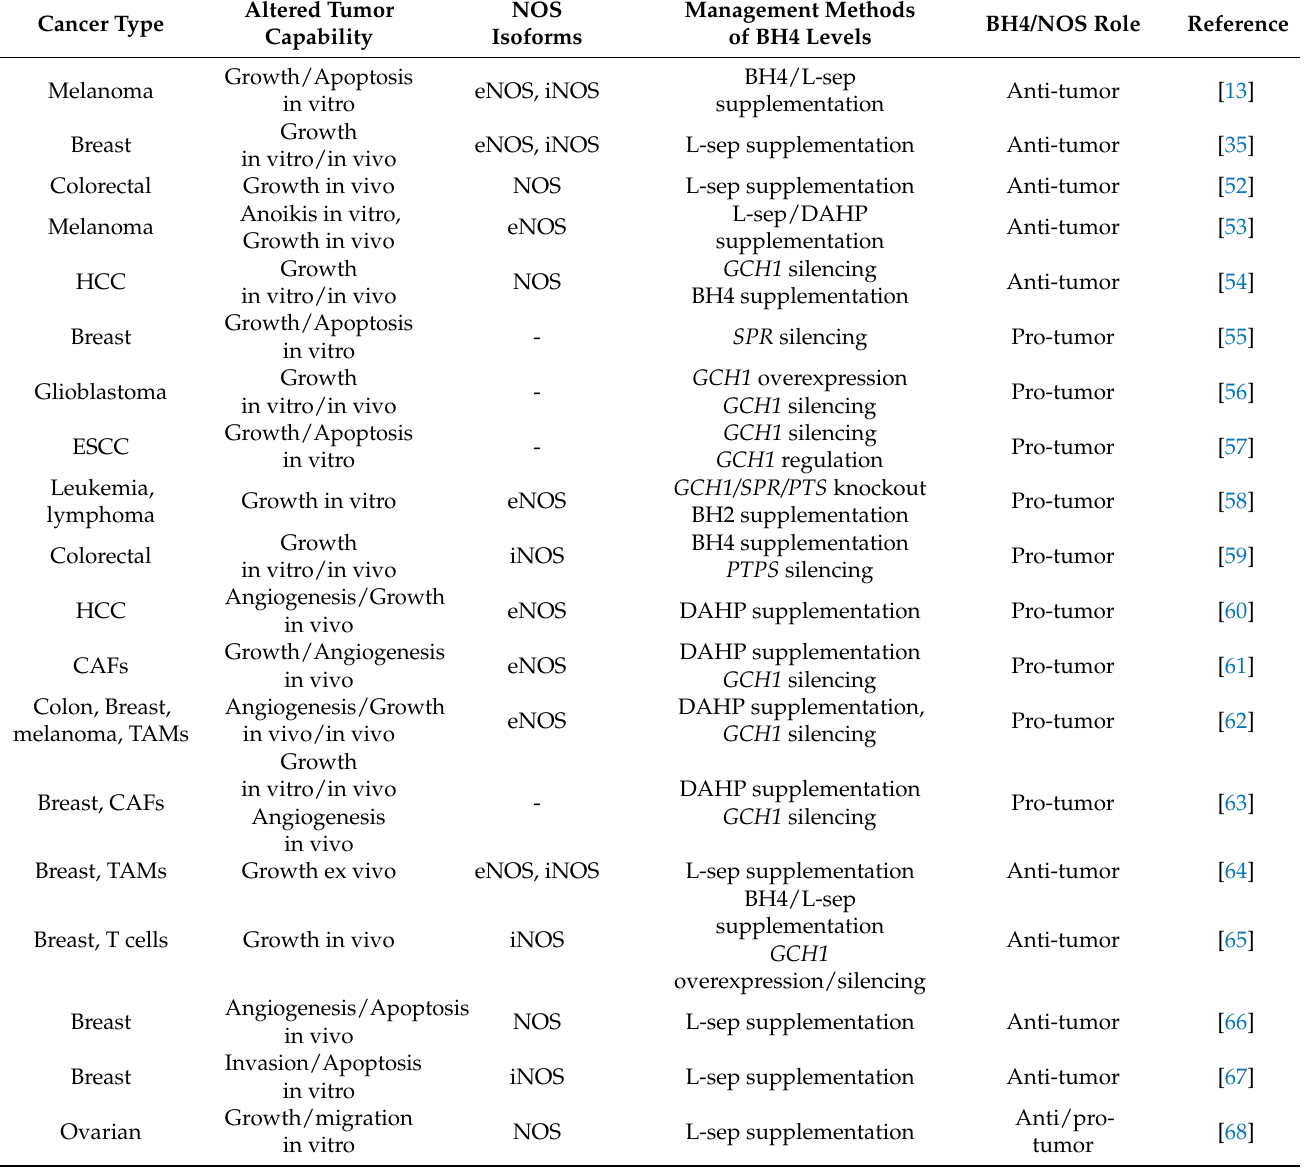
Table 1. Studies showing the role of BH4 and NOS activity in the progression of different types of cancers. Cancer